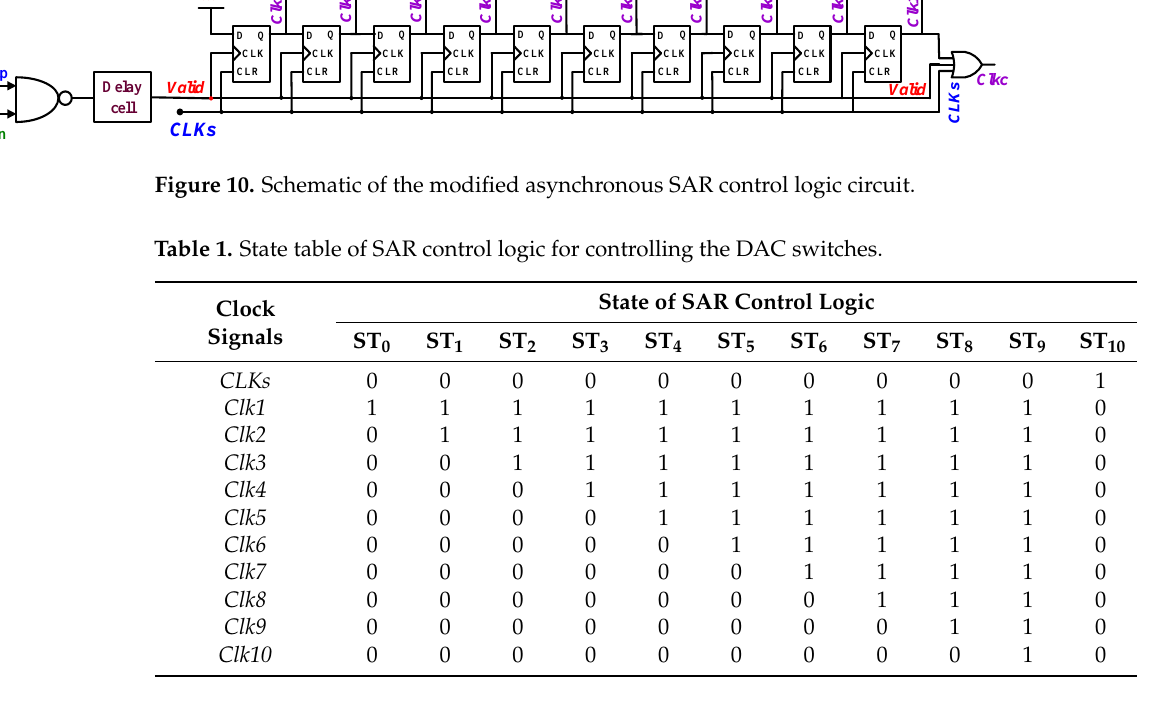
Figure 10. Schematic of the modified asynchronous SAR control logic circuit.